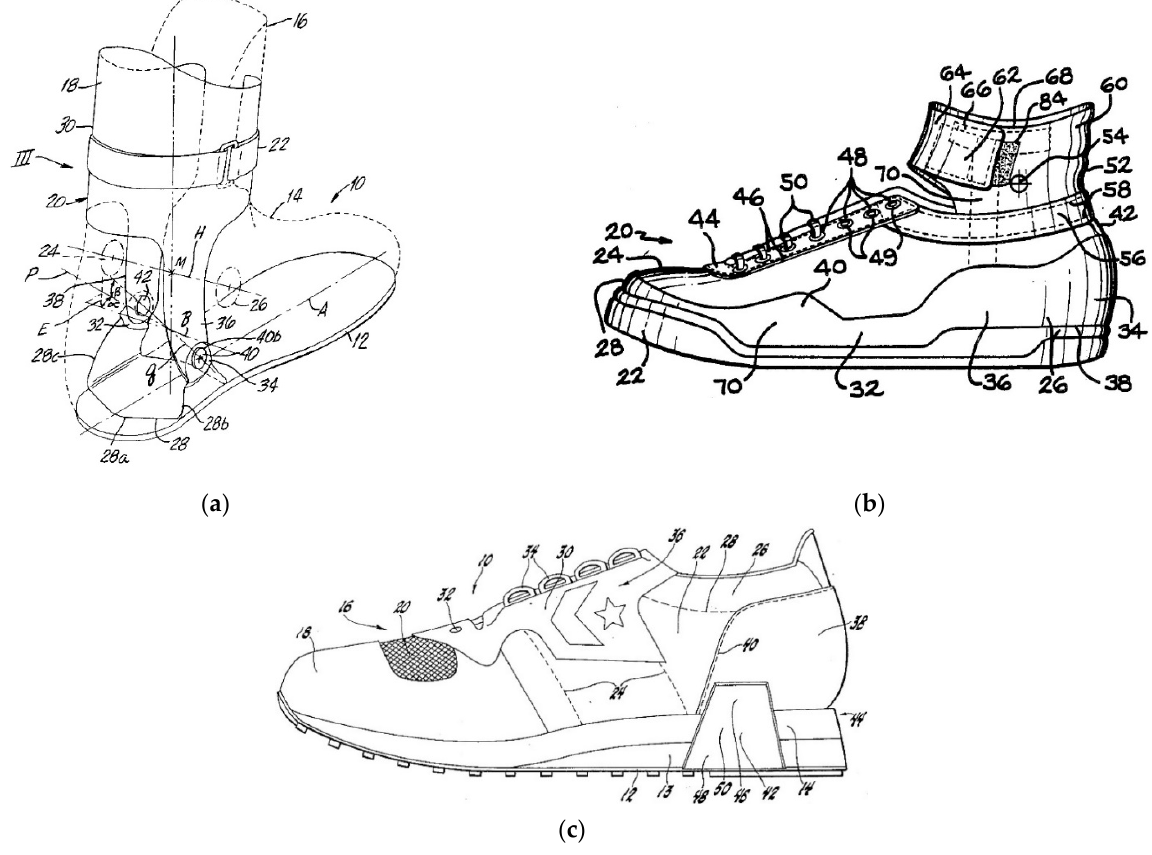
Figure 13. Patents of Orthosis for sports use: ( a ) Shoe, in particular, Sport Shoe or Orthopaedic Stocking with Ankle Stabilisation [63], ( b ) Athletic Shoe [64], and ( c ) Running Shoe Sole with Heel Tabs [65].